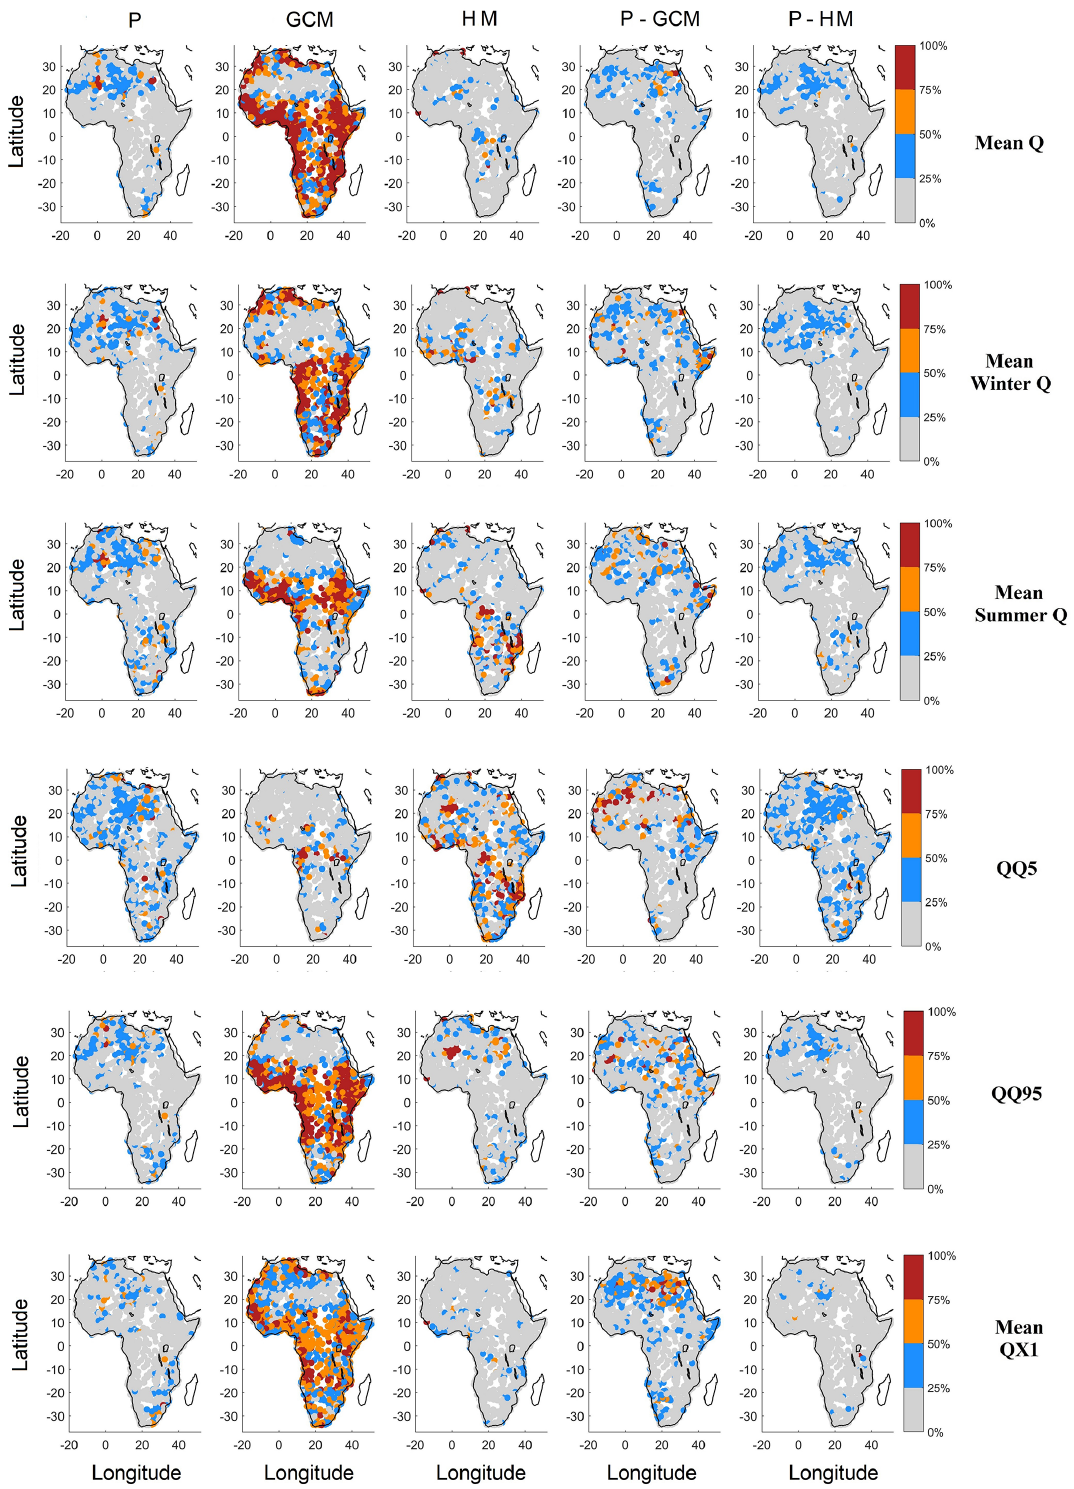
Figure 8. Spatial distribution of the five main contributors to variance (columns) for each of the six streamflow metrics (rows), using the four best precipitation datasets (ensemble 4 in Table 4). Each dot represents the watershed